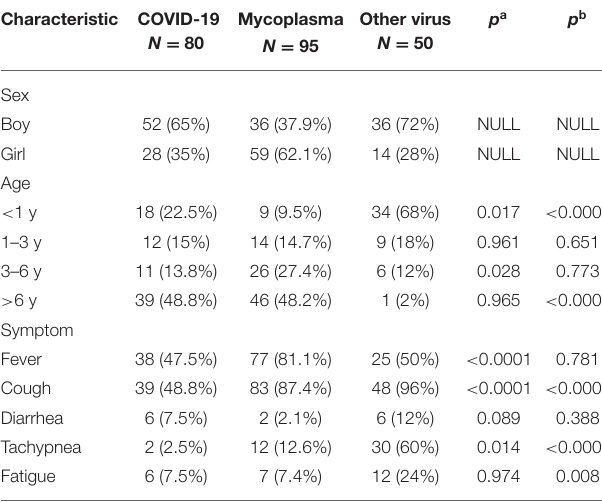
TABLE 1 | The Clinical features of pediatric